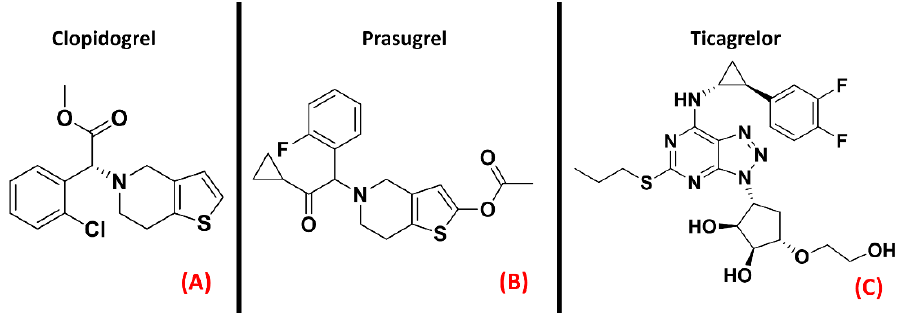
Figure 4. The chemical structures of the selective and irreversible P2Y 12 receptor antagonists Clopidogrel ( A ) and Prasugrel ( B ). Ticagrelor, a selective, reversible, allosteric P2Y 12 receptor antagonist, is also reported ( C ).